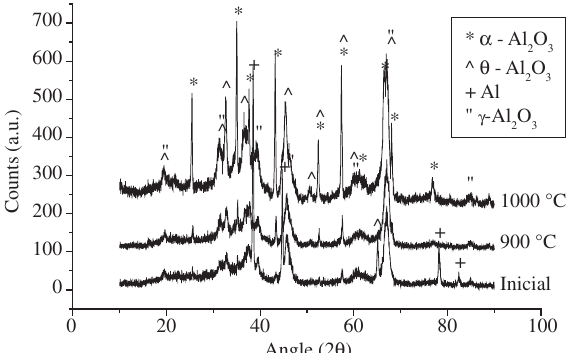
Figure 3. X ray spectra of the residue of the Al paint heated to 900 and 1000 °C for 65 hours.